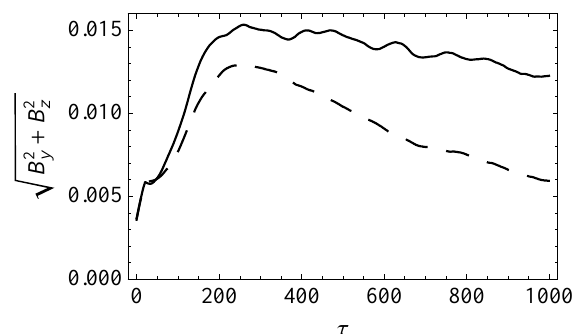
Fig. 8. Temporal evolution of the perpendicular magnetic field en- ergy in simple (solid) and expanding box (dashed) hybrid models. Note that significant effects appear only after τ ∼ 200 as in the case of thermal